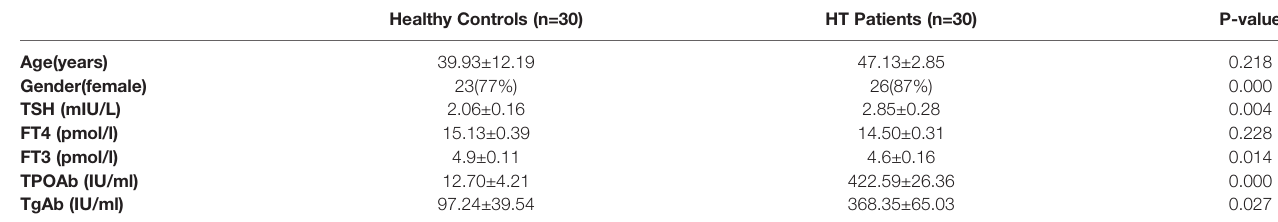
TABLE 1 | Characteristics of patients with HT and healthy controls in this